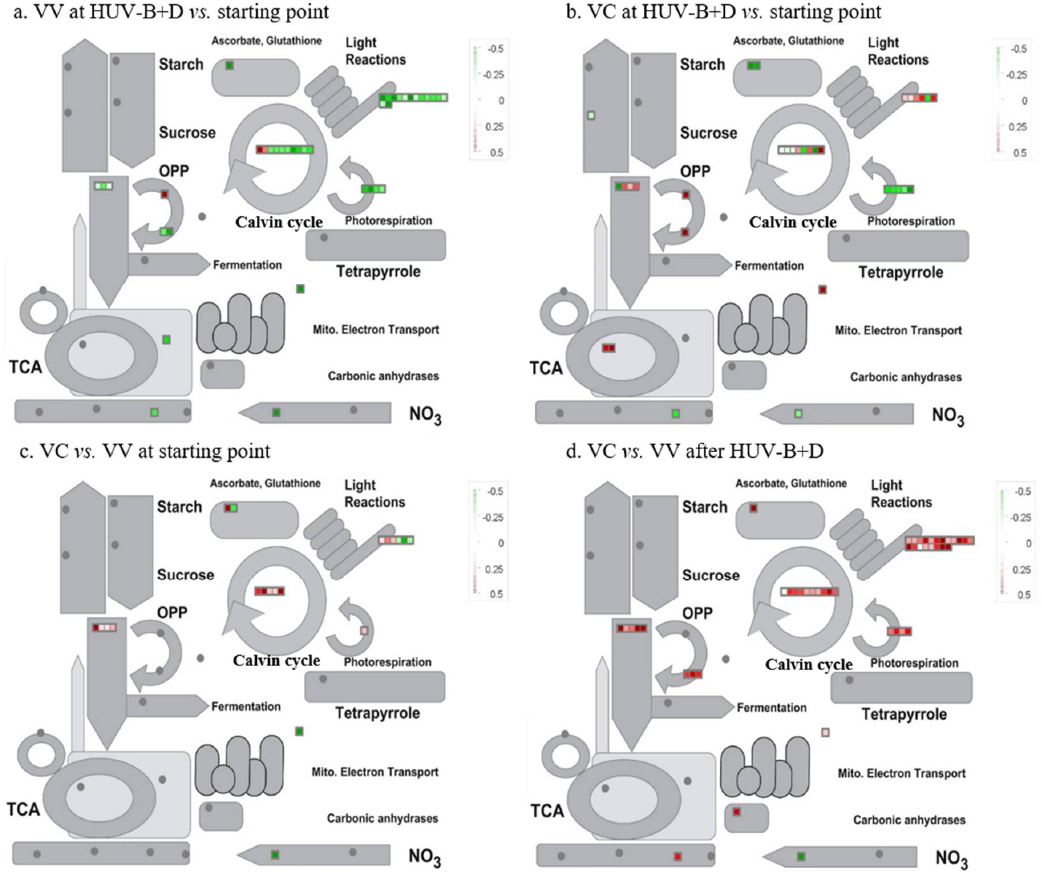
Figure 4. Metabolic pathways of proteins identified in VIGS-vector and VIGS-CtPPO C. terniflora DC. Leaves were collected at the starting point and after HUV-B+D treatment. The proteins were grouped into functional categories related to primary metabolism and changes in abundance were visualized using MapMan software. Each square and color indicates the fold-change of a differentially expressed protein. Green and red indicate a decrease and increase, respectively, in fold change compared with the corresponding group: ( a ) comparison of proteins in VIGS-vector leaves after HUV-B+D treatment at starting point, ( b ) comparison of proteins in VIGS-CtPPO leaves after HUV-B+D treatment at starting point, ( c ) comparison of proteins at starting point in VIGS-CtPPO and VIGS-vector plants, and ( d ) comparison of proteins after HUV-B+D treatment in VIGS-CtPPO and VIGS-vector plants. Abbreviations: OPP, oxidative pentose phosphate; CHO, carbohydrate; TCA, tricarboxylic acid cycle.